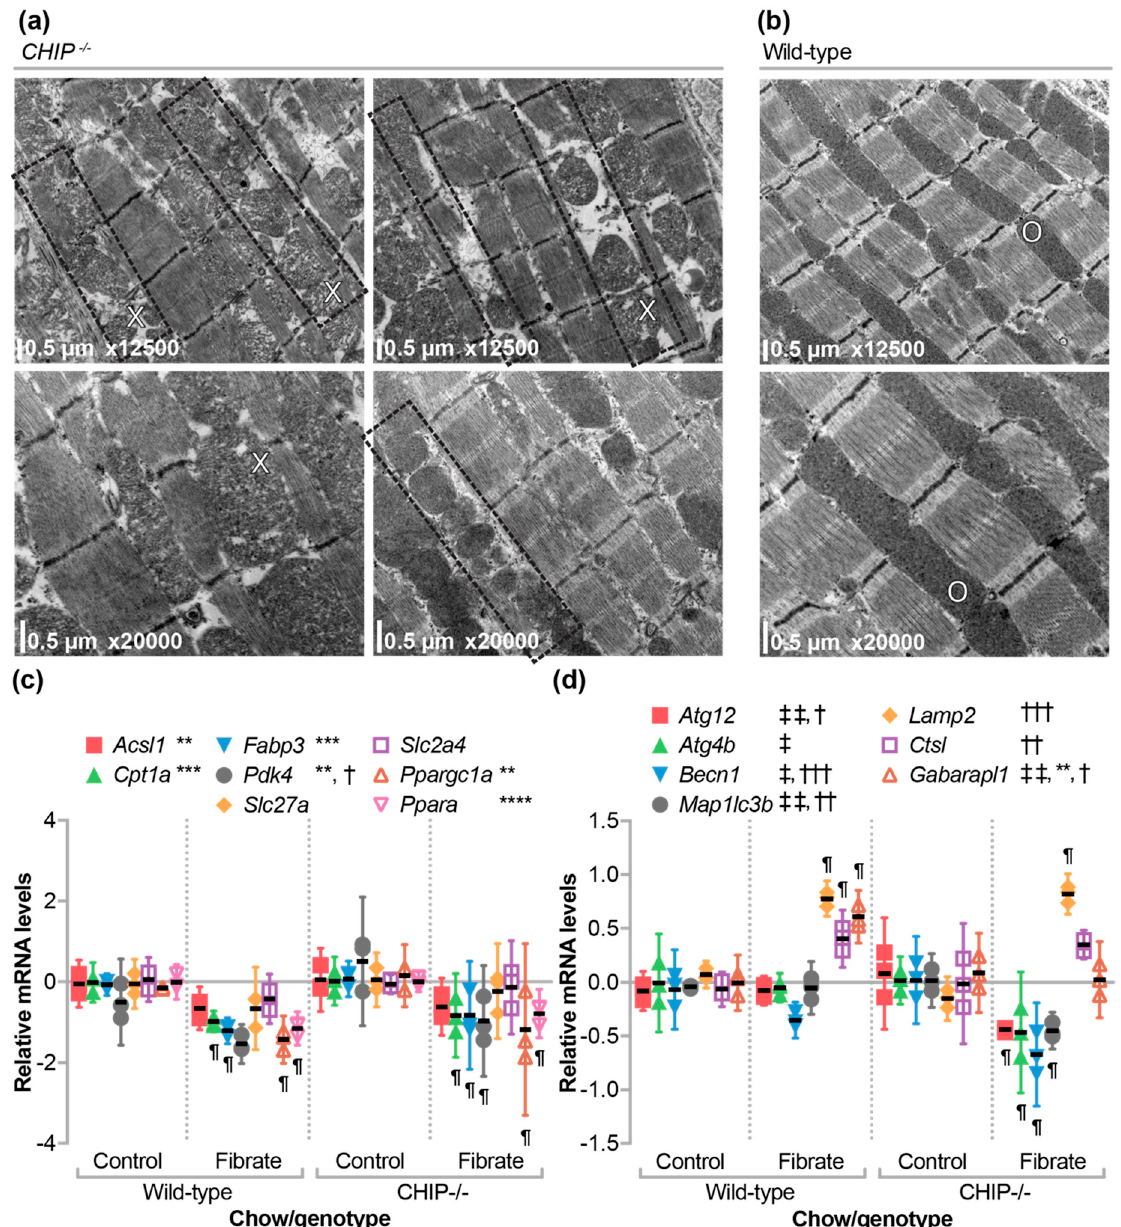
Figure 6. The effect of fenofibrate on mitochondrial ultrastructure and gene expression in the absence of CHIP. Transmission electron micrographs of left ventricle tissue from ( a ) CHIP − / − and ( b ) wild-type mice. Expanded sarcoplasm regions are observed throughout CHIP − / − hearts (outlined in boxes). Alterations in mitochondria were also observed in CHIP − / − hearts (X) and compared to wild-type hearts (O). Quantitative PCR analysis of gene expression of ( c ) metabolic or ( d ) autophagy/mitophagy mRNA in hearts from either wild-type or CHIP − / − mice fed control or fenofibrate chow,represented by dot plot and summarized by the mean ± 95% CI, N = 3 animals per genotype per condition: **, ***, **** indicate p < 0.01, 0.001, 0.0001 on the main effect of chow, † , †† , ††† indicate p < 0.05, 0.01, 0.001 on the main effect of genotype, or ‡ , ‡‡ indicate p < 0.05, 0.01 the interaction of chow and genotype via two-way ANOVA. ¶ indicates the Tukey’s post-test < 0.05 in comparing fibrate to control conditions within genotypes.